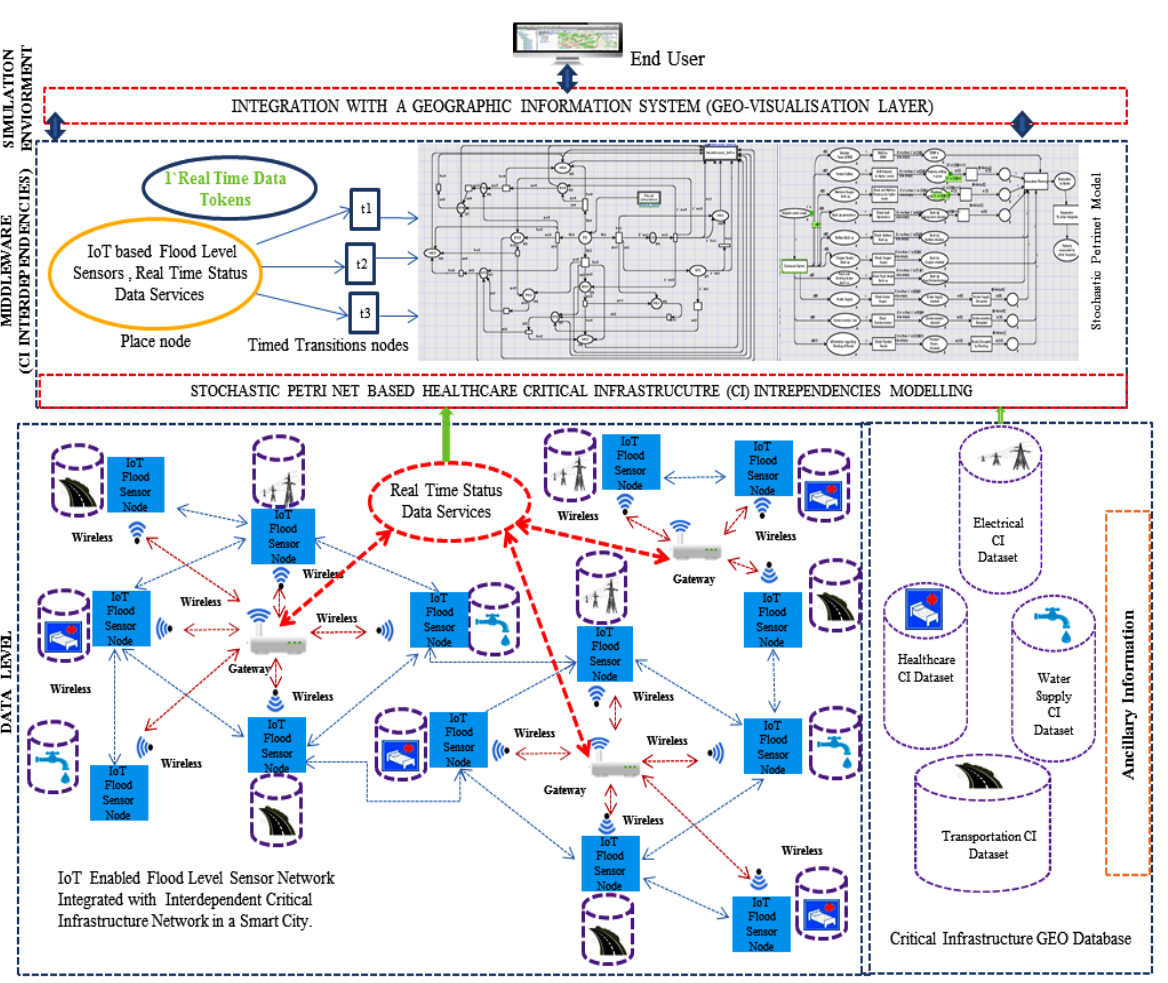
Figure 3 . Architecture for IoT based flood sensor network integrated with stochastic Petrinet based interdependent healthcare CI network simulation